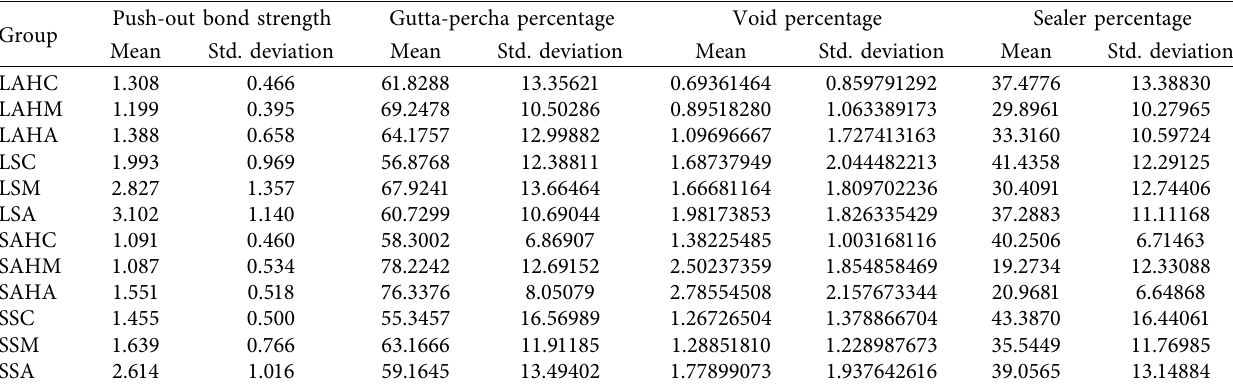
Table 1: Mean and standard deviation of PBS, percentage of gutta-percha, percentage of voids, and percentage of sealer in the study groups. Push-out bond strength Gutta-percha percentage Void percentage Sealer percentage Group Mean Std. deviation Mean Std. deviation Mean Std. deviation Mean Std. deviation LAHA